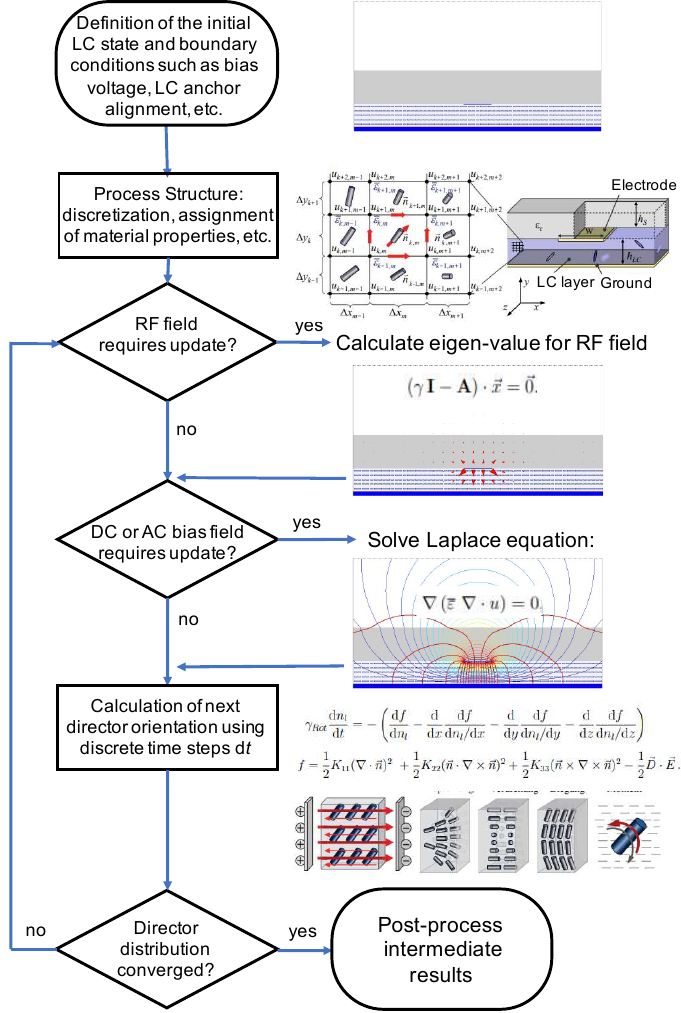
Figure 12. Flow chart of the in-house software tool “ SimLCwg” , combining the finite difference method for static fields to simulate the director dynamics and the finite difference frequency domain method for a full RF wave simulation [74,229,230].